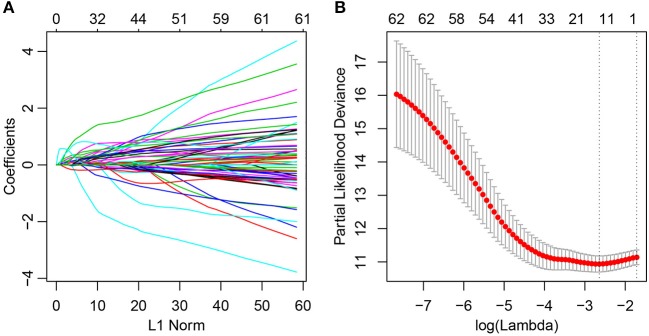
Construction of the prognosis prediction model for lung adenocarcinoma patients by LASSO. (A) The changing trajectory of each independent variable. The horizontal axis represents the log value of the independent variable lambda, and the vertical axis represents the coefficient of the independent variable. (B) Confidence intervals for each lambda.